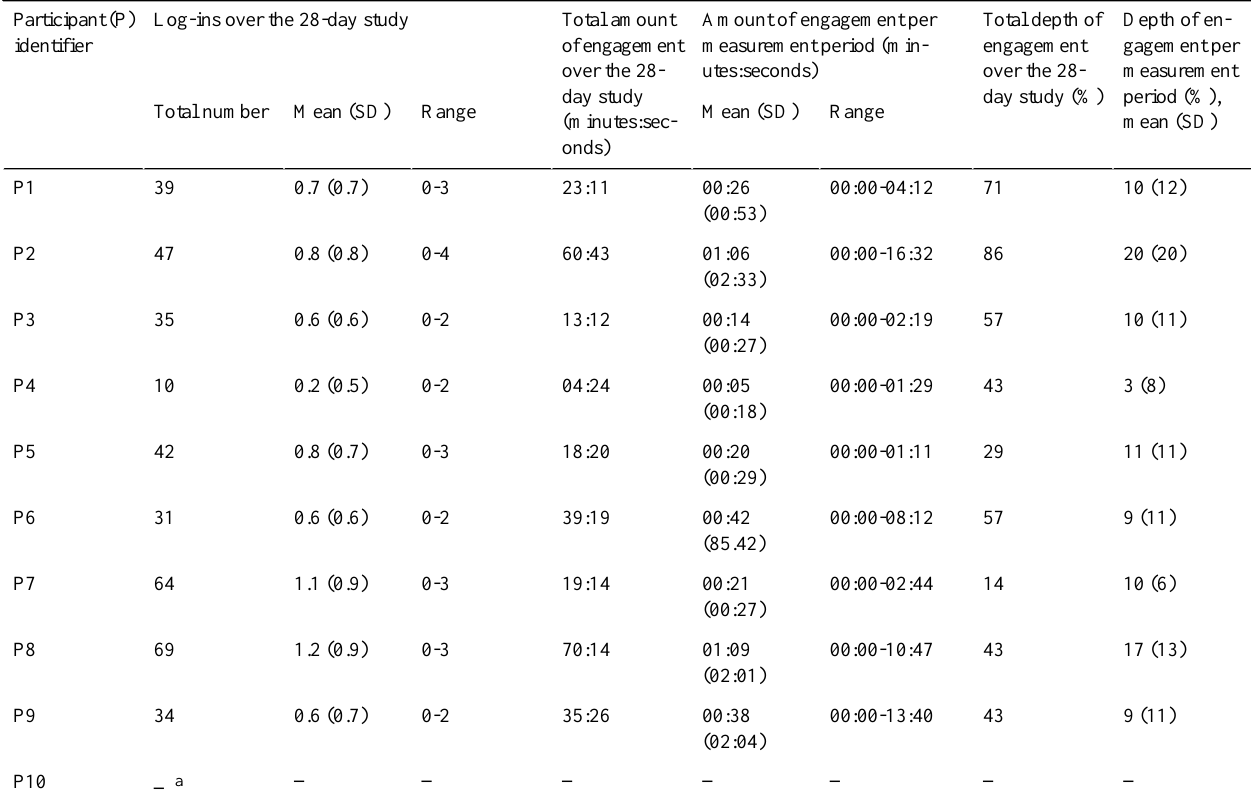
Table 5. Descriptive statistics of participants’frequency, amount, and depth of engagement with the Drink Less app.